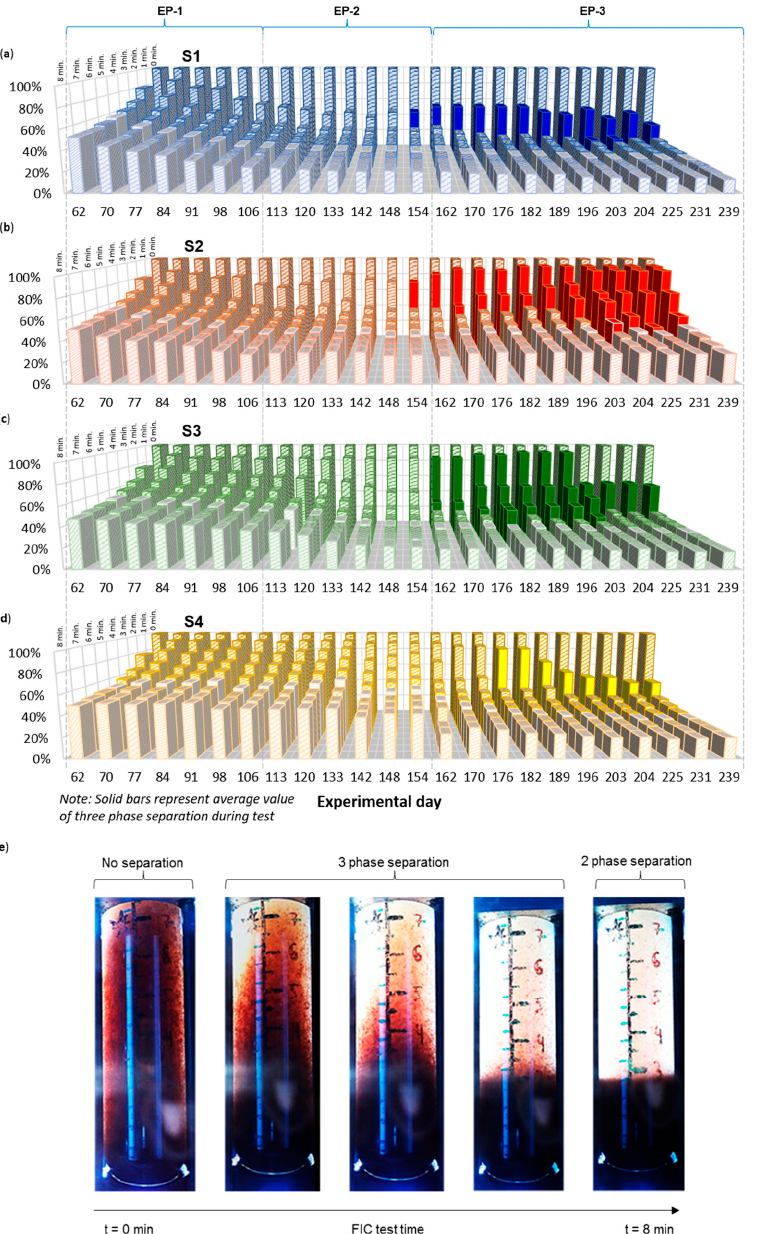
Figure 5. Mixed liquor centrifugation during experimental period: FIC test—Separated sludge volumes as % of original sample volume in ( a ) S1, ( b ) S2, ( c ) S3 and ( d ) S4, ( e ) separation phases during FIC test in centrifuged mixed liquor from S2 on day 204. Vertical dotted lines indicate start of experimental phases.